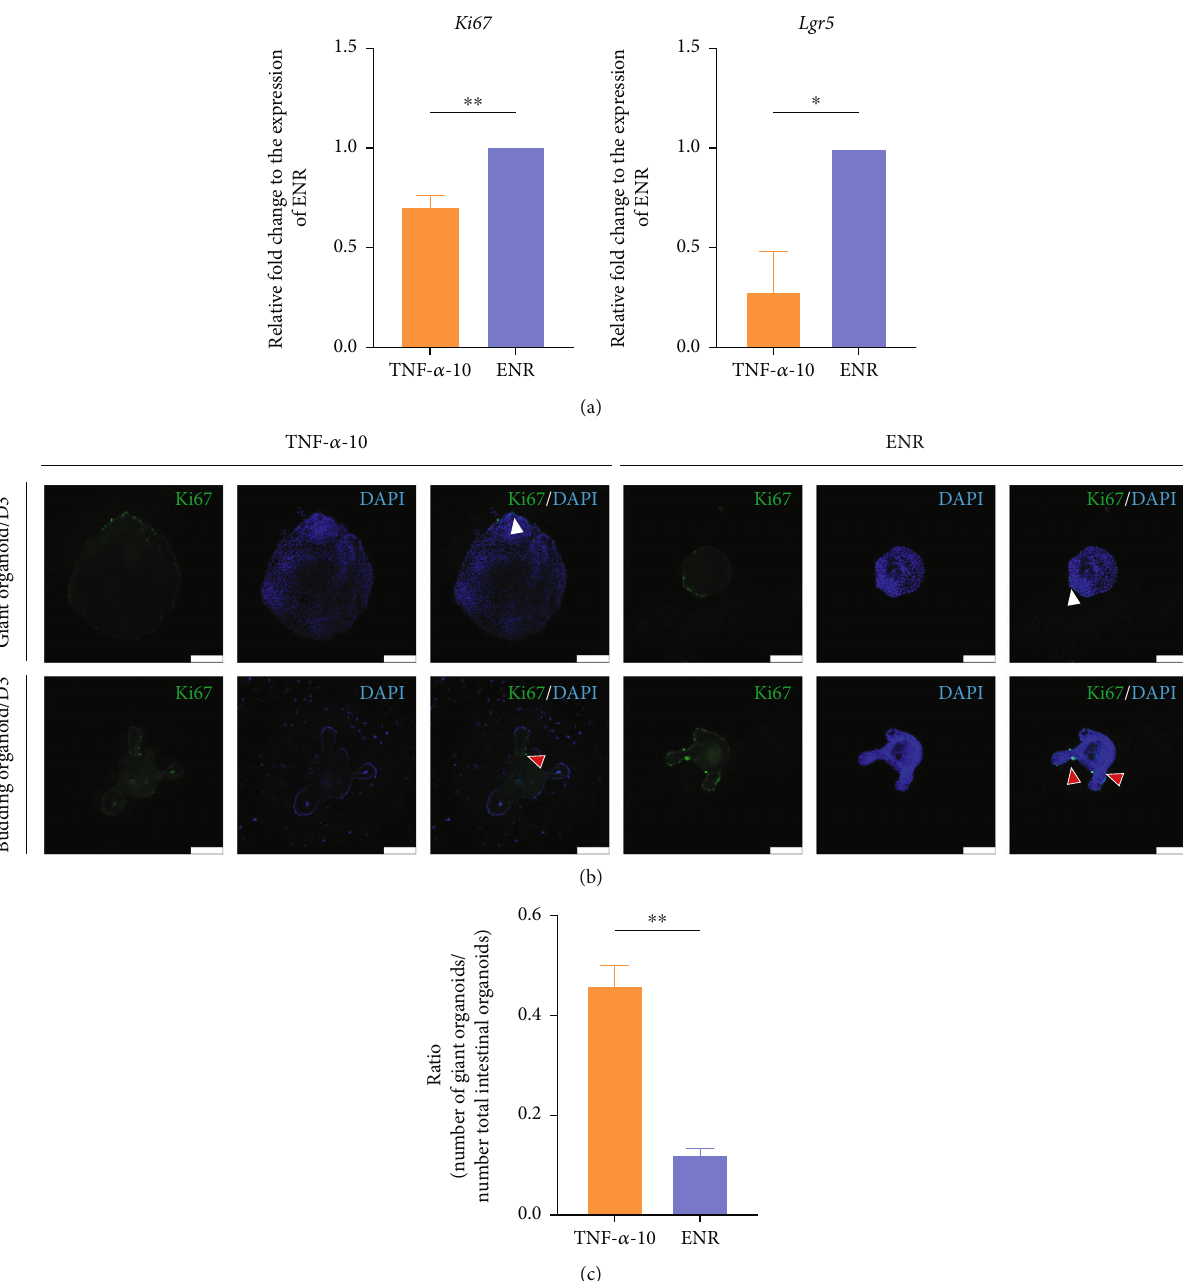
Figure 2: Proliferation ability assay of intestinal organoid with TNF- α treatment. (a) qRT-PCR analyses of proliferation marker Ki67 and ISC marker Lgr5 expression in organoids cultured under the indicated conditions ( n = 1 well). P values were determined by two-sided unpaired Student ’ s t -test. Gapdh was used as a control to normalize the expression of target genes. ∗ P < 0 : 05 ; ∗∗ P < 0 : 01 ; ∗∗∗ P < 0 : 001 . (b) Immuno fl uorescence staining of Ki67 (green) of intestinal organoids after 3 days of culture in groups TNF- α -10 ( fi rst column) and ENR (second column). Images of typical giant organoids ( fi rst row) and budding organoids (second row). Blue stain (DAPI) indicates the nucleus. Scale bars = 100 μ m. White arrows pointed to the Ki67 + cells, and red arrows pointed to typical buddings. (c) The ratio of the number of giant organoids and the total number of intestinal organoids (giant organoids plus budding organoids). DAPI nucleus labeling was used in morphological di ff erences of organoid cultures to visualize the budding organoids and giant organoids. ∗ P < 0 : 05 ; ∗∗ P < 0 : 01 ; ∗∗∗ P < 0 : 001 . The experiments (a, c) were independently repeated at least three times with similar